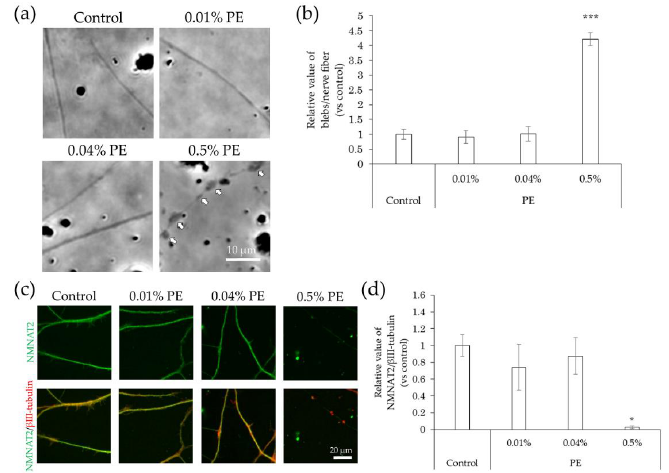
Figure 8. Effects of PE treatment on bleb formation and NMNAT2 expression in nerve fibers. After culturing for 3 days, the effects of the direct interaction between hiPSC-SN and PE were assessed. ( a ) Morphological changes in nerve fibers 24 h after treatment with PE. The arrows indicate blebs. ( b ) Number of blebs at various concentrations of PE. *** p < 0.001, vs. absence of PE (Dunnett’s test). ( c ) Double labelling of NMNAT2 (red) and β III-tubulin (green) in nerve fibers at various concentrations of PE. ( d ) NMNAT2-immunoreactive (ir) nerve fiber length normalised to β III-tubulin- ir nerve fiber length in identical areas at various concentrations of PE. * p < 0.05 vs. absence of PE (Steel’s test). All values represent the mean ± standard deviation of more than three wells. NMNAT2: nicotinamide mononucleotide adenylyltransferase 2; PE: